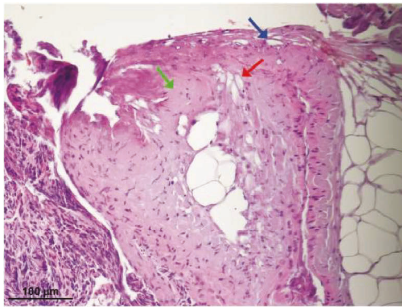
Figure 2: Vacuolation (red arrow), cleft formation (blue arrow), and hyalinization of collagen (green arrow) in spleen capsule following the use of a tissue-welding